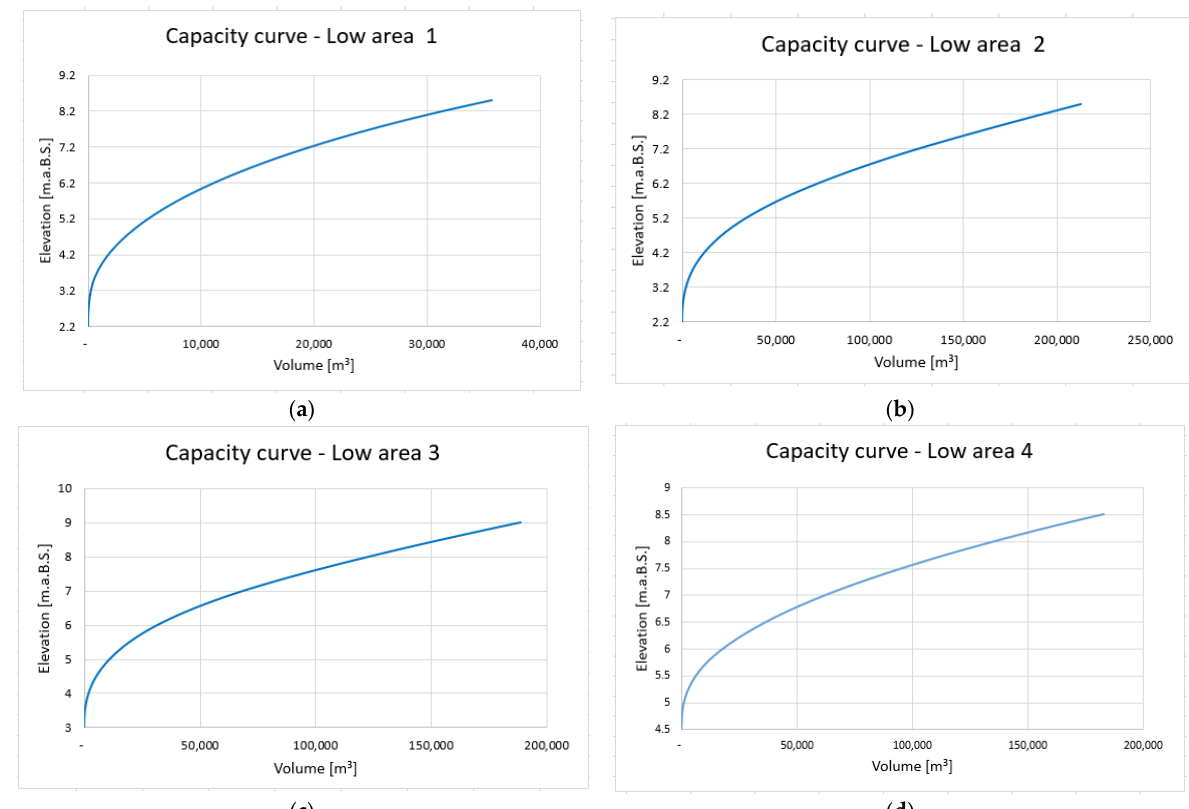
Figure 14. Storage–elevation curves for depression areas: ( a ) “La Ceas” roundabout area; ( b ) Multi- purpose Hall area; ( c ) Summer cinema area; and ( d ) Pacii-Isaccei-Unirii-Babadag streets area.